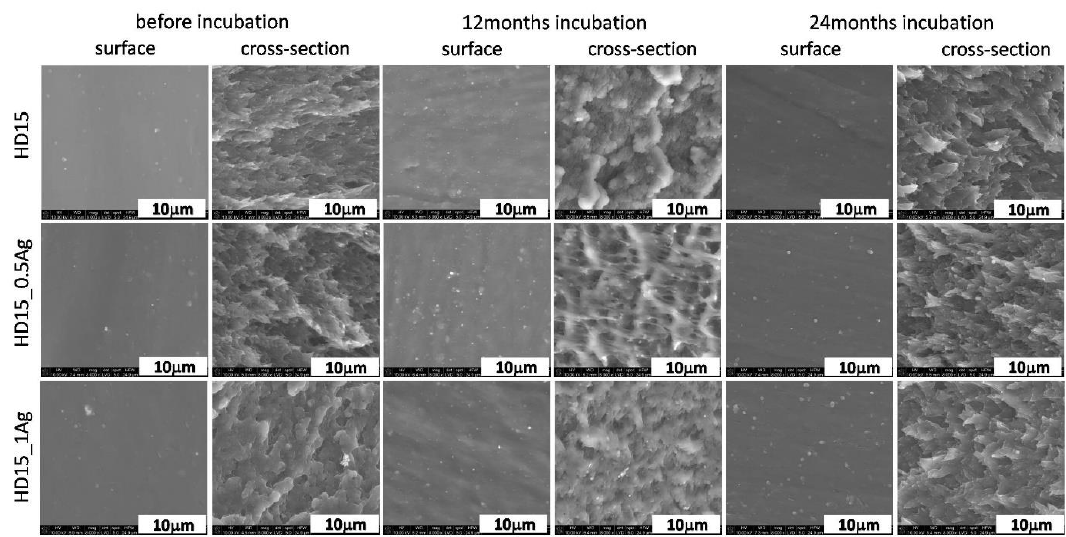
Figure 3. SEM images of surface and cross-section of pure polymer (HD15) and polymer containing 0.5 wt % and 1.0 wt % of silver nanoparticles AgNPs before and after 12 and 24 months of incubation.